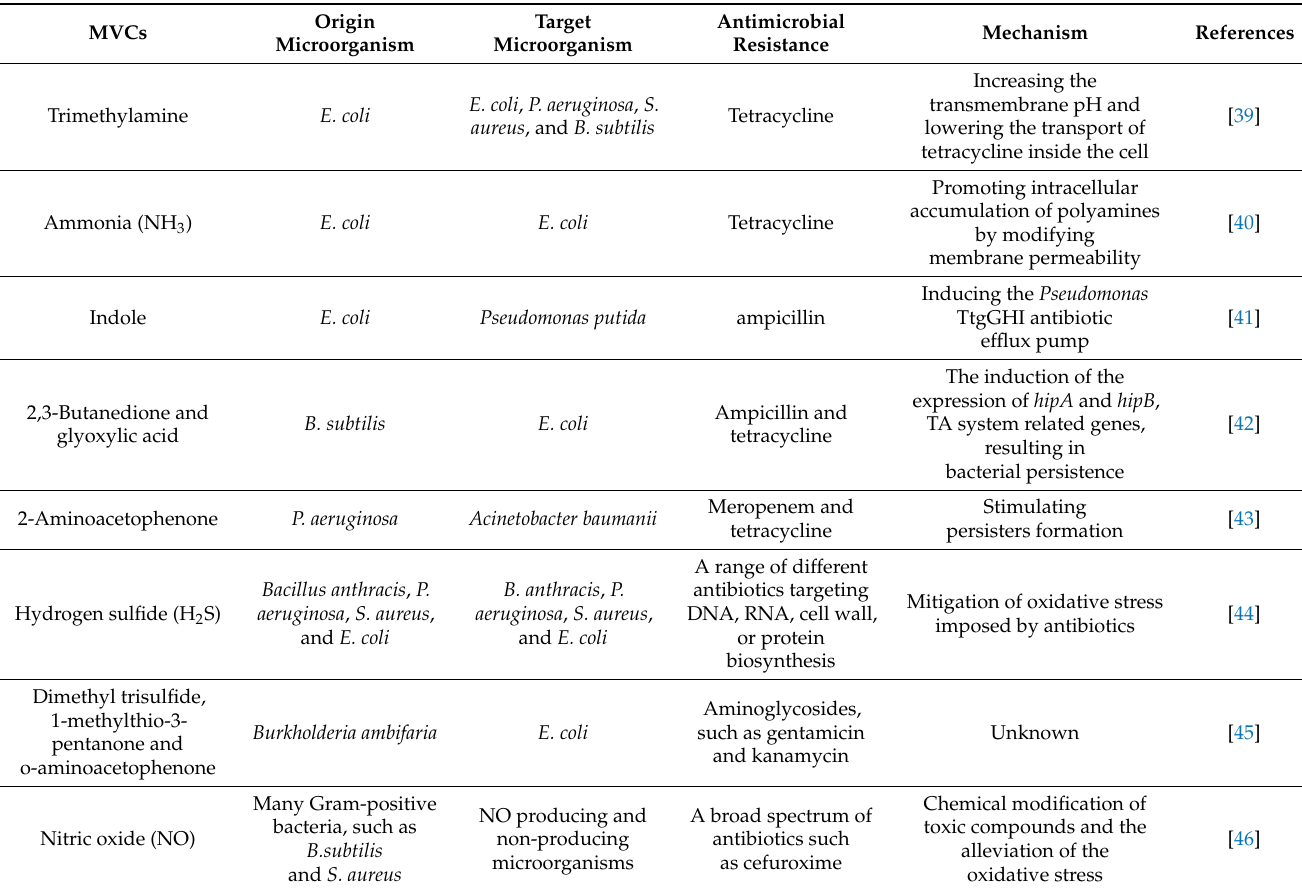
Table 2. Modulation of AMR by microbial volatile compounds